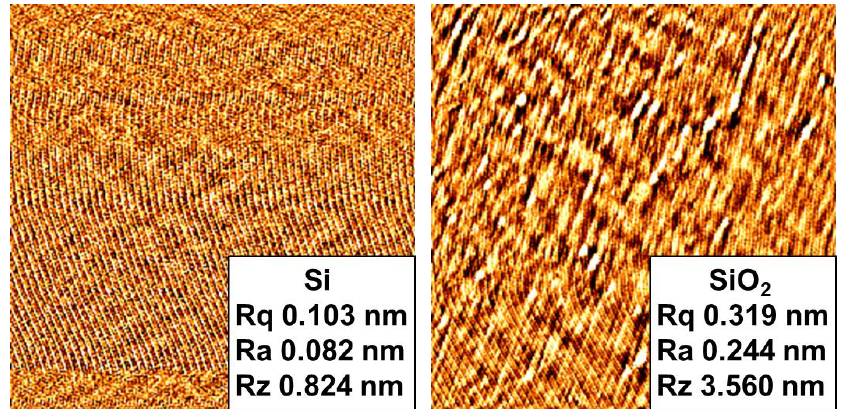
Figure 1. Surface roughness of Si and SiO 2 wafers before plasma treatment.